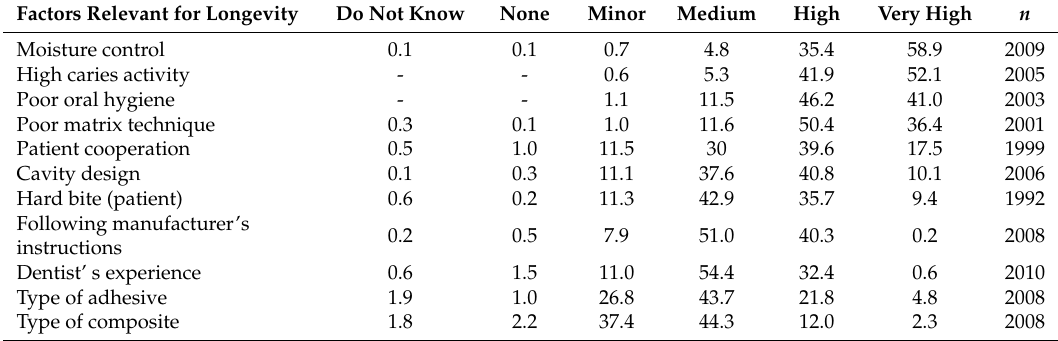
Table 3. To which extent do you think the following factors have significance for the longevity of a Class II composite restoration (%)? Factors Relevant for Longevity